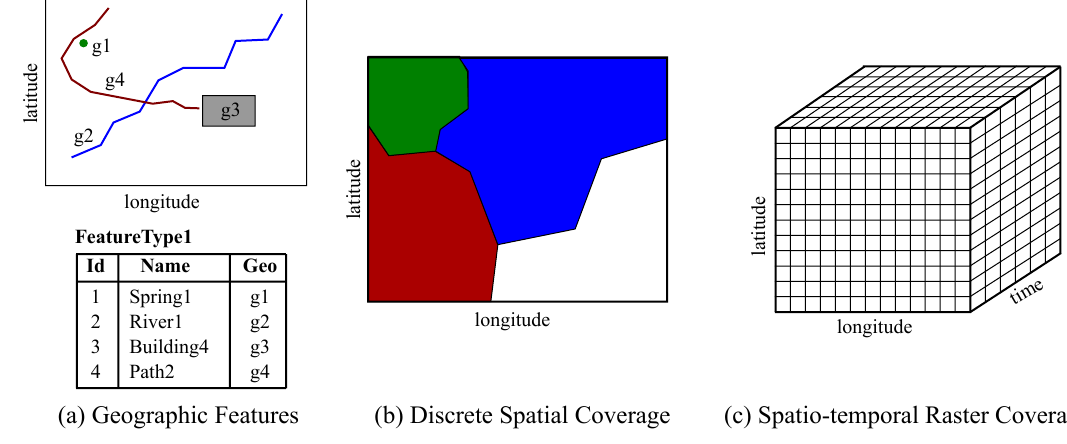
Figure 3. Illustration of geospatial features and